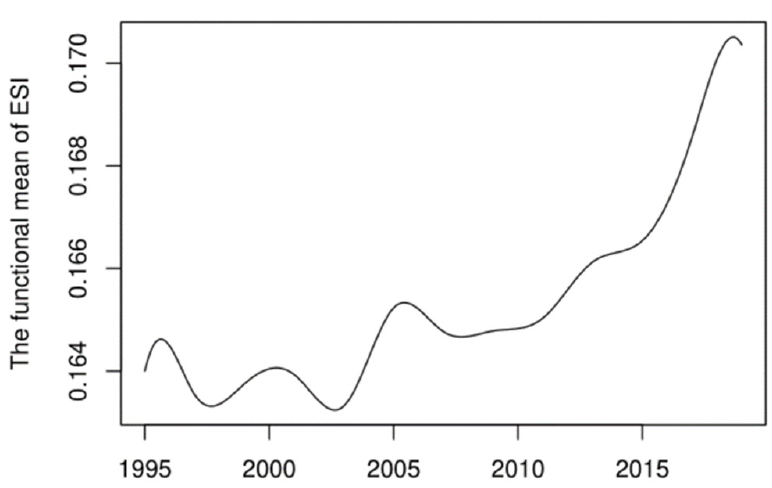
Figure 3. Function curve of global energy security.